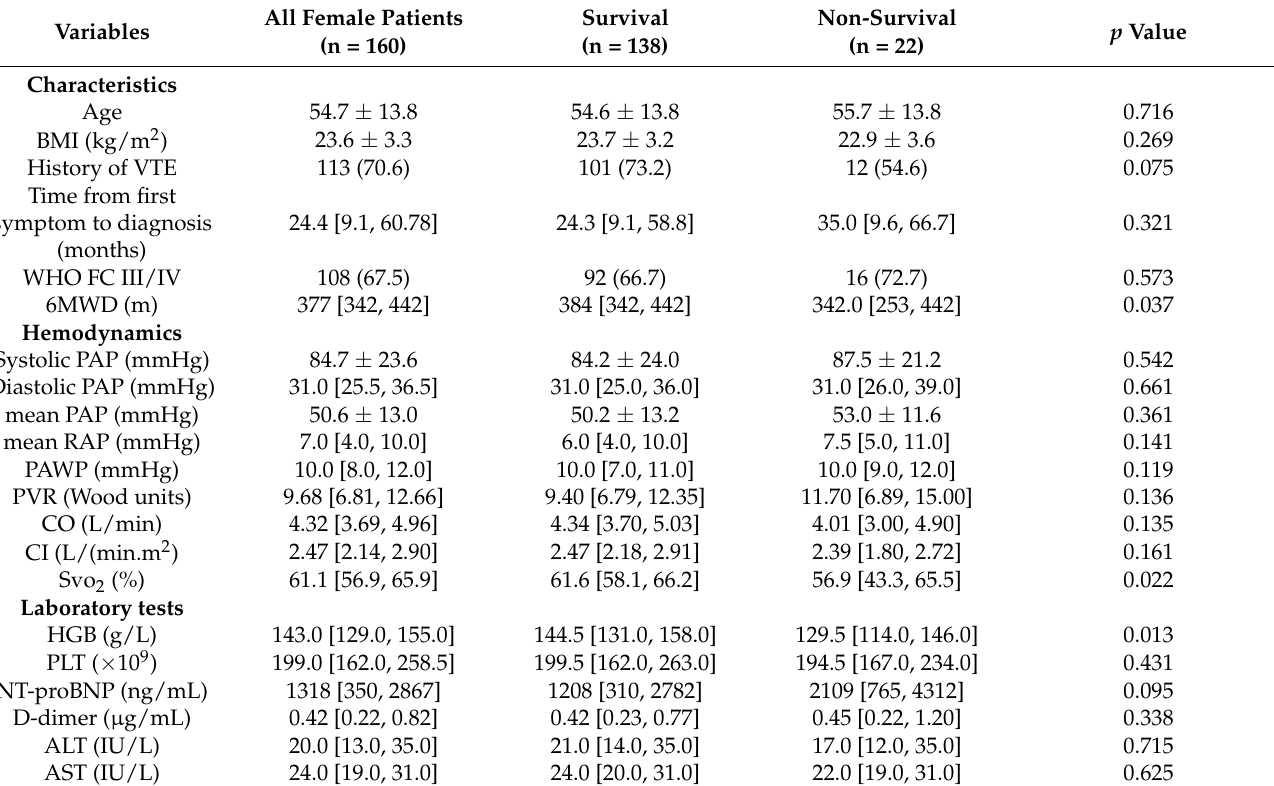
Table 1. The clinical characteristics of female CTEPH